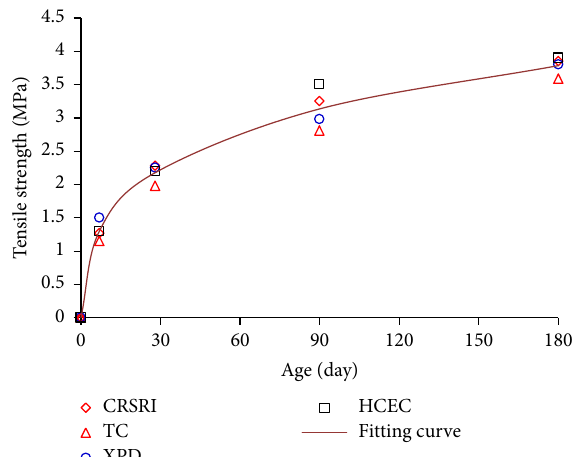
Figure 13: The splitting tensile strength of the dam concrete.